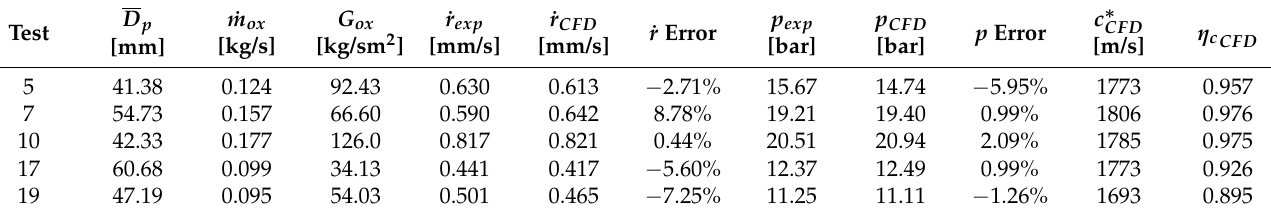
Table 6. Numerical results of GOX-HDPE motor